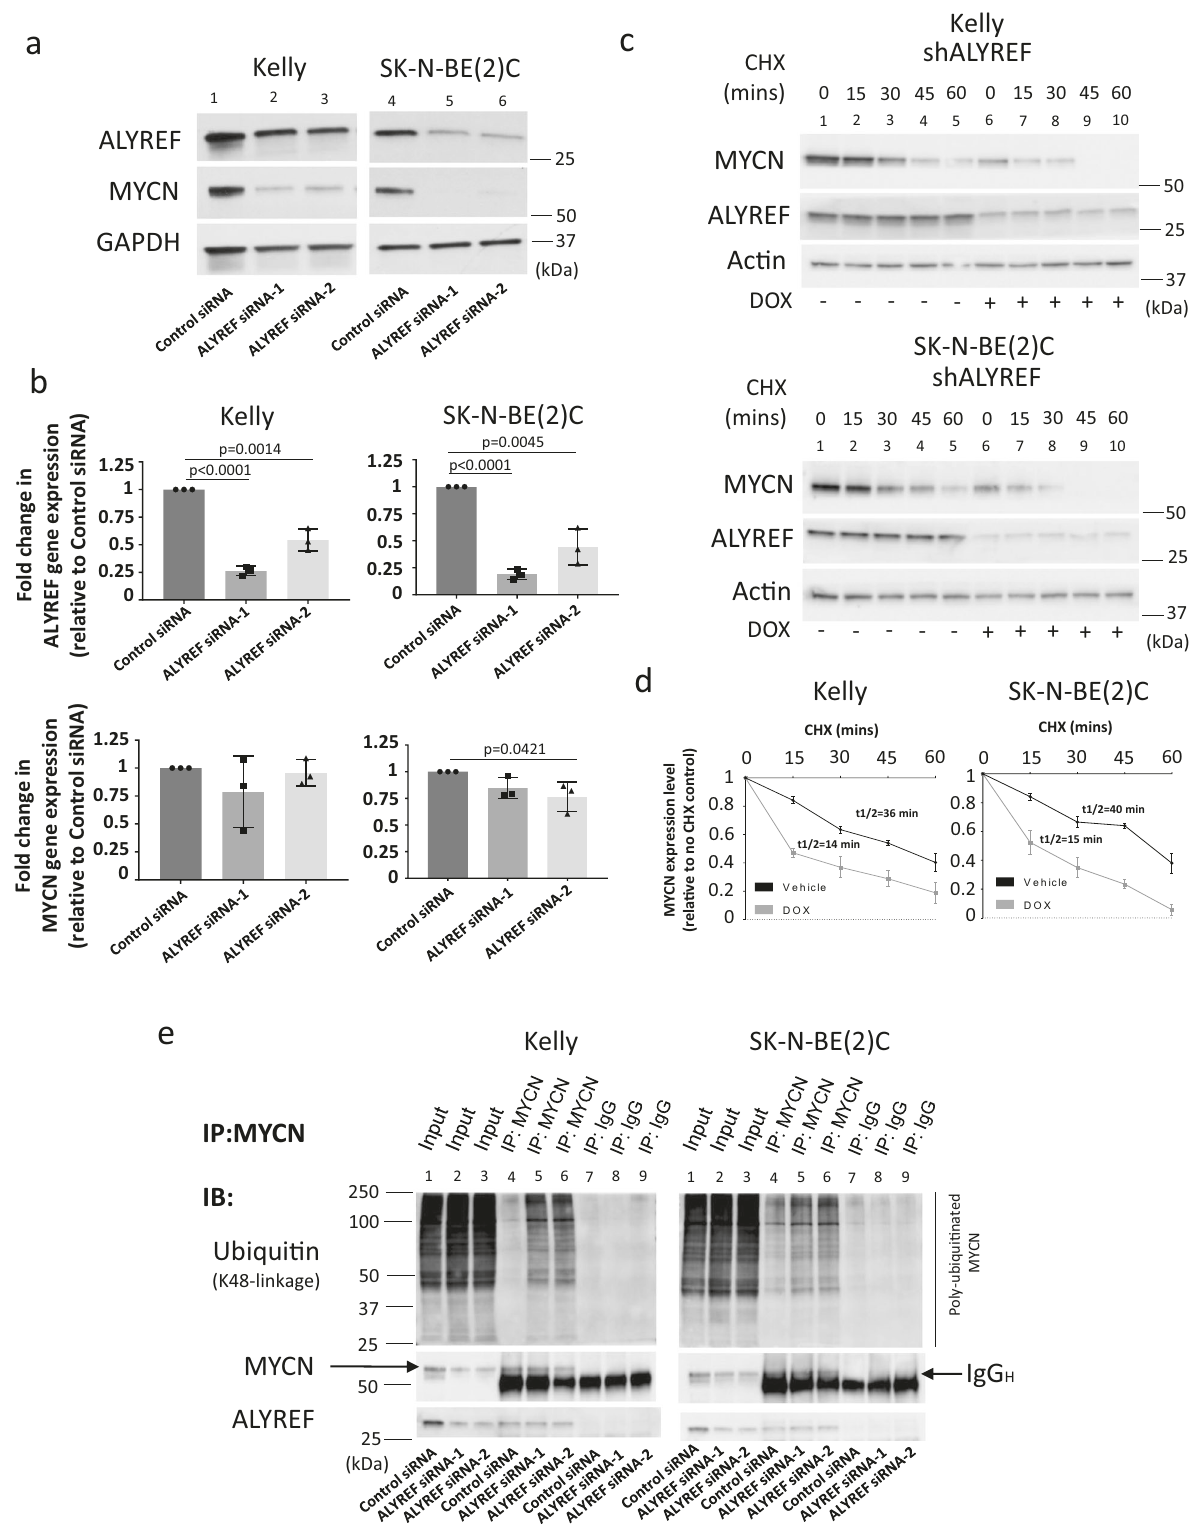
strati fi cation. Integrative Genomic Viewer showed that ALYREF bound the USP3 intronic region 6.8 kb from the TSS (Fig. 5c). To con fi rm the ChIP-seq data, we performed a ChIP assay with an anti-ALYREF antibody or control IgG antibody (IgG) followed by real-time PCR with primers targeting a negative control region (Control; 2000 bp downstream TSS) or the putative